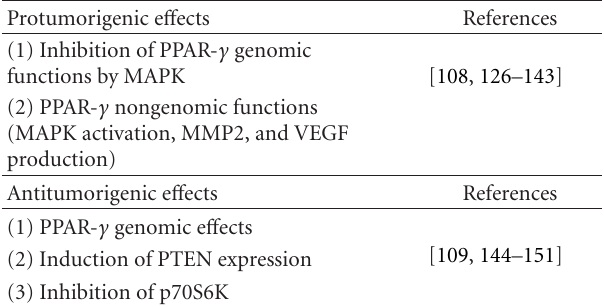
Table 1: Mechanisms underlying PPAR- γ pro- and antitumorigenic e ff ects. Protumorigenic e ff